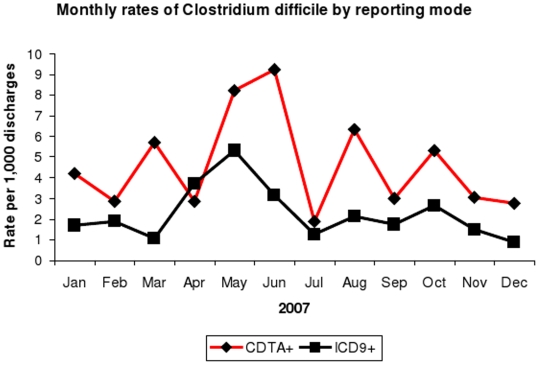
Monthly rates of Clostridium difficile by reporting mode.